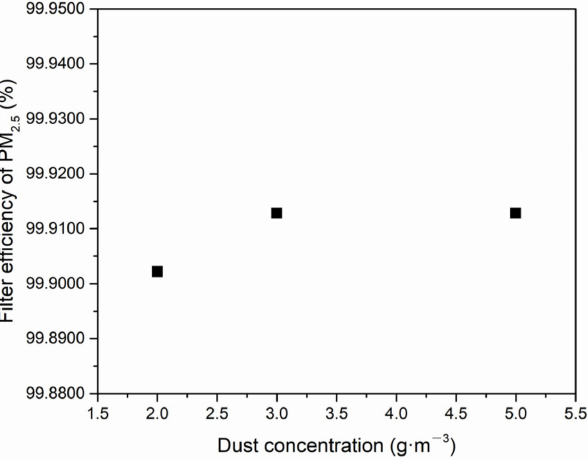
Figure 8. PM 2.5 filtration efficiency of filter media at different inlet dust